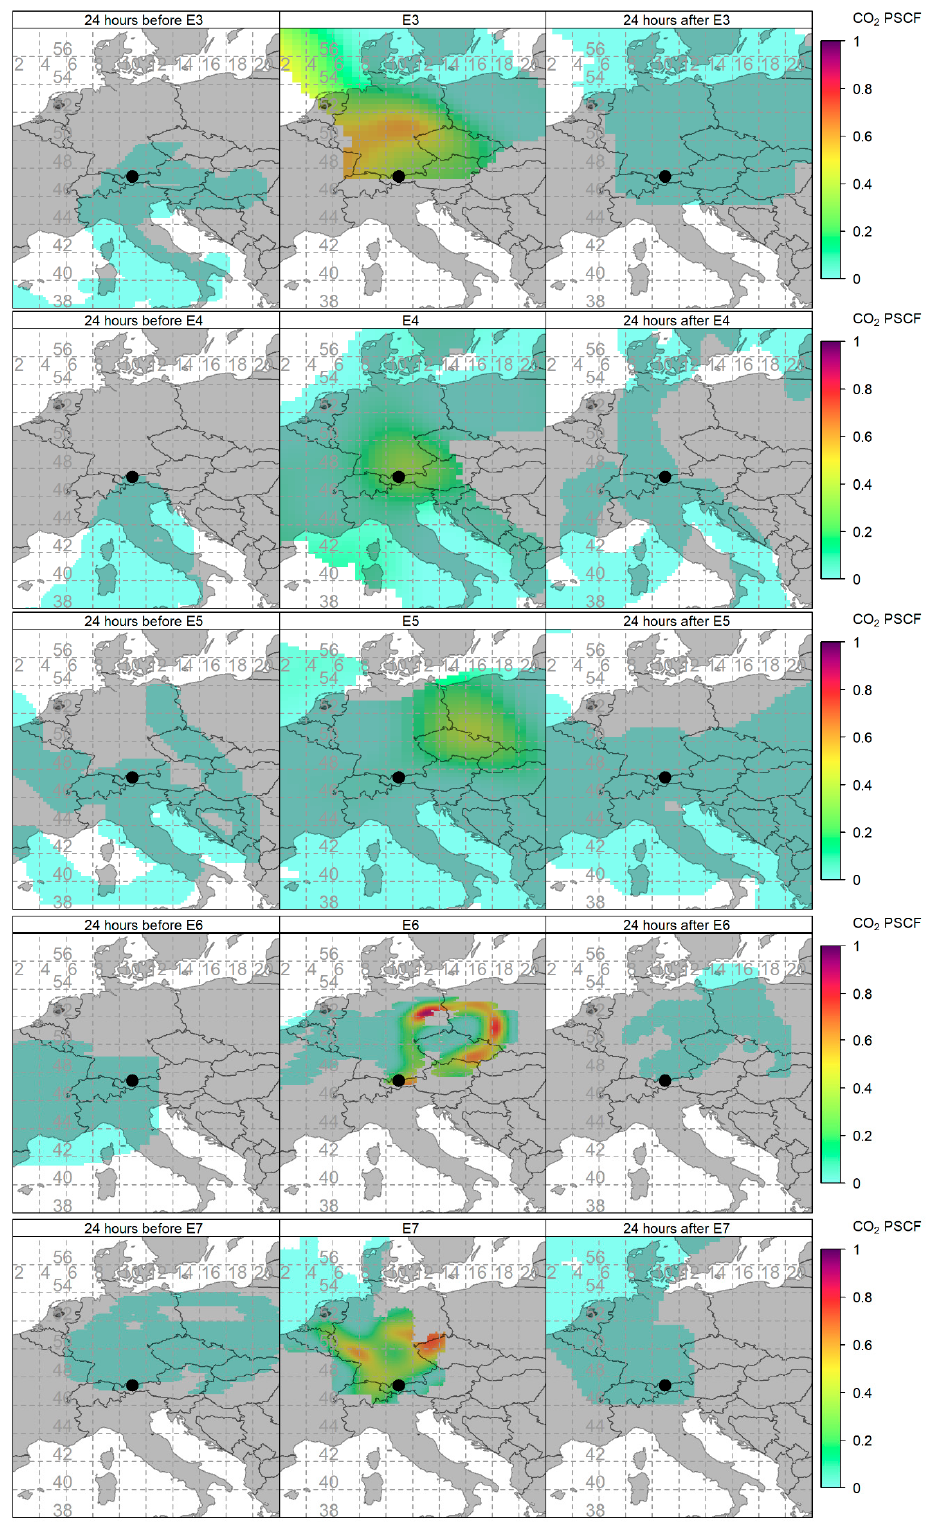
Figure 7. Potential source contribution function (PSCF) plot of CO 2 . The color of the maps shows the respective probabilities. For each event (E3 to E7), three plots are shown including 24 h before the event, during the event, and 24 h after the event (left, center, and right, respectively). Blue to purple colors (0 ≤ P ij ≤ 1) identify regions from which elevated CO 2 potentially originated. Black circles show the position of the UFS study